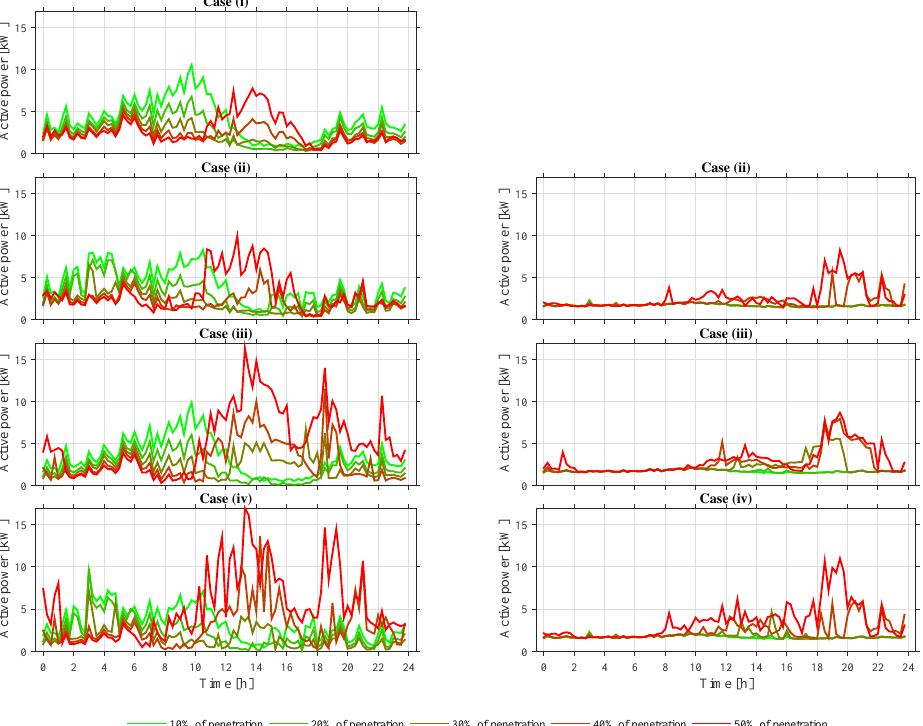
Figure 6. In the first column: Power losses of DN passive elements for each case. In the second column: Power losses of DN active elements for each case.